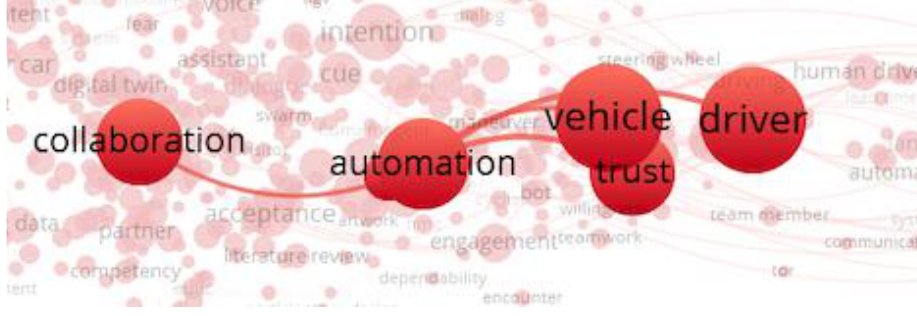
Figure 10. Intelligence dependency.